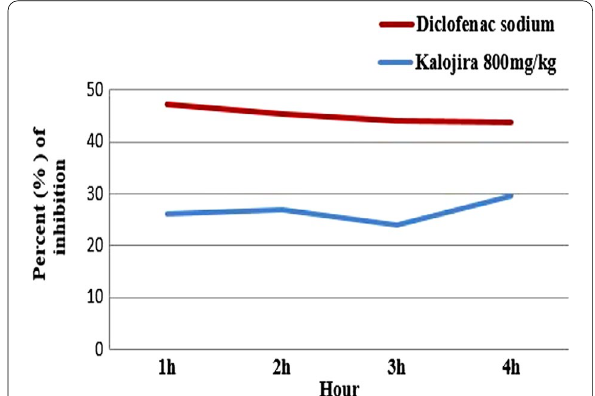
Fig. 1 Time course in the changes of percent inhibition on carrageenan-induced paw edema volume of BC at 1, 2, 3, and 4 h at the dose of 800 mg/kg, p.o.